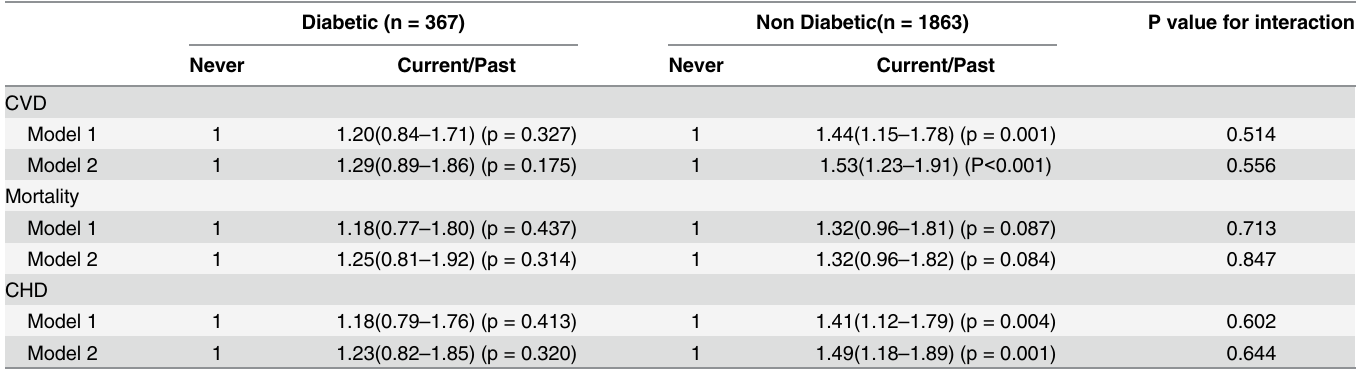
Table 4. The risk of different smoking groups between diabetics and non-diabetics for cardiovascular and coronary heart diseases and all -cause mortality, after pooling current and past smokers in a single category. Tehran Lipid and Glucose study (1999 – 2012).